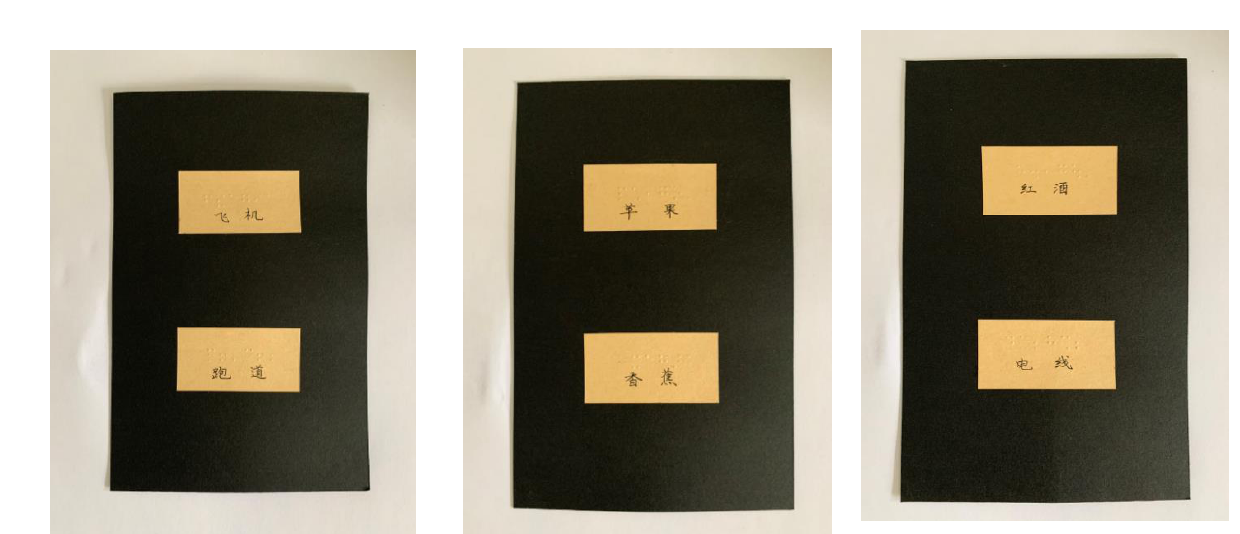
Figure 2. Word cards used in Experiment 1. ( A ) The agreement condition in the experimental word pair; ( B ) the semantically related filler word pair; ( C ) the semantically irrelevant filler word pair. Below the illustrations are the materials used in the experiment. In the three images: “ 飞机 ” means “airplane” in Chinese, “ 跑道 ” means “runway”, “ 苹果 ” means “apple”, “ 香蕉 ” means “banana”, “ 红酒 ” means “wine”, “ 电线 ” means “wire”.